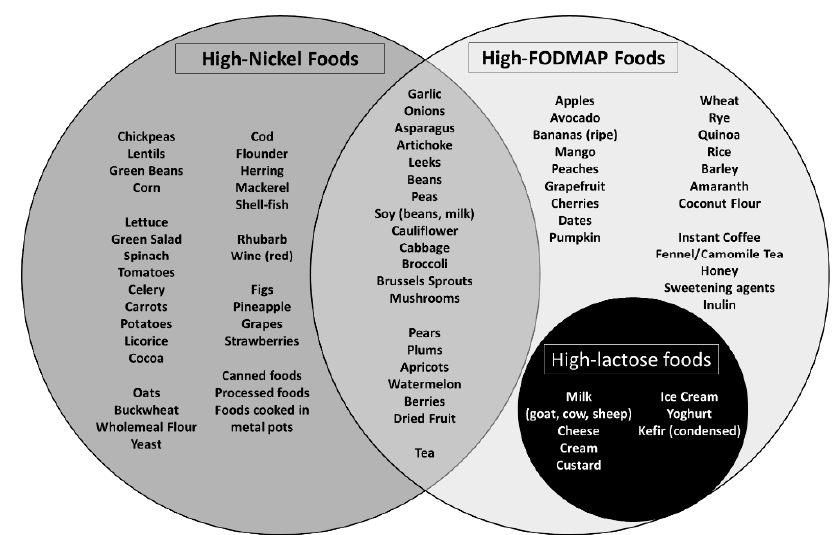
Figure 1. Foods with high nickel (Ni) content and their possible overlap with foods rich in fermentable oligo-, di-, and monosaccharides and polyols (FODMAPs). Here we report some of the main foods